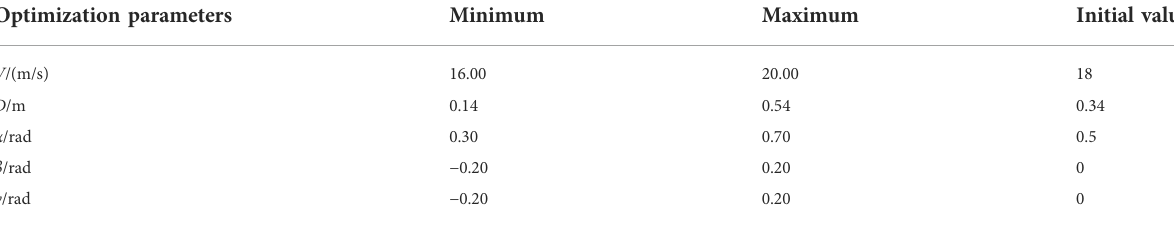
TABLE 1 Range of different initial collision parameters and the initial value setting of the optimization model. Optimization parameters